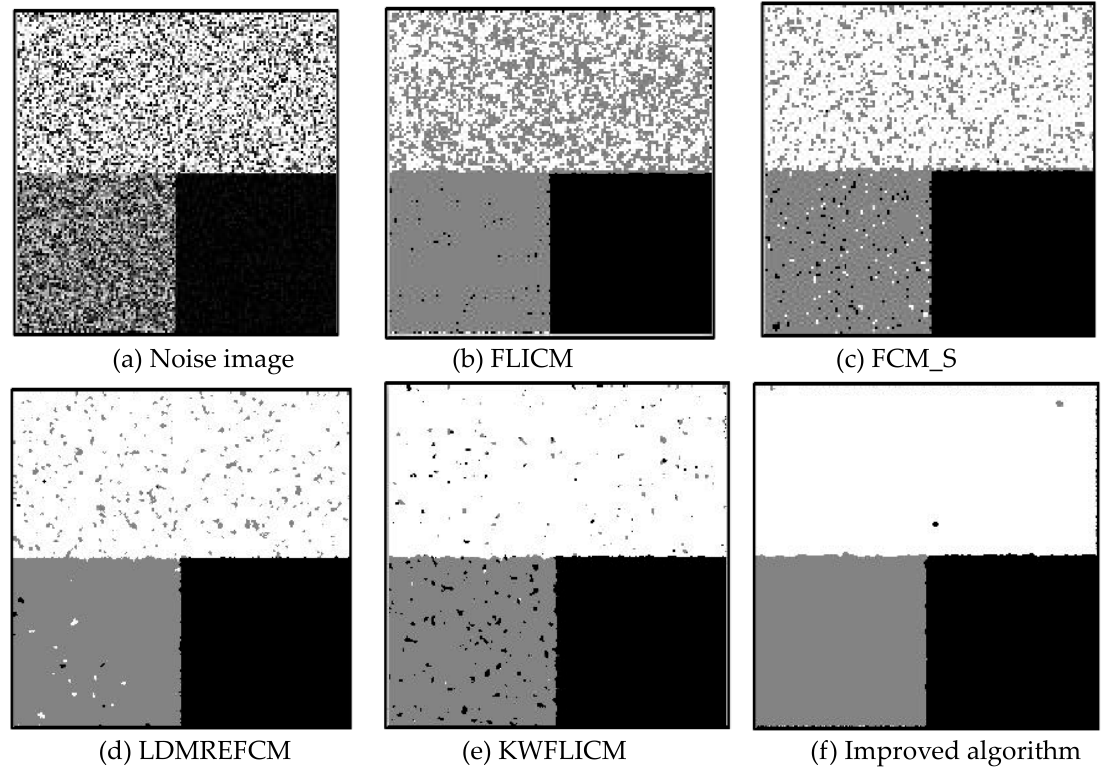
Figure 12. Multiplicative noise disturbing brain CT images ( a ) and the segmentation results ( b – f ).